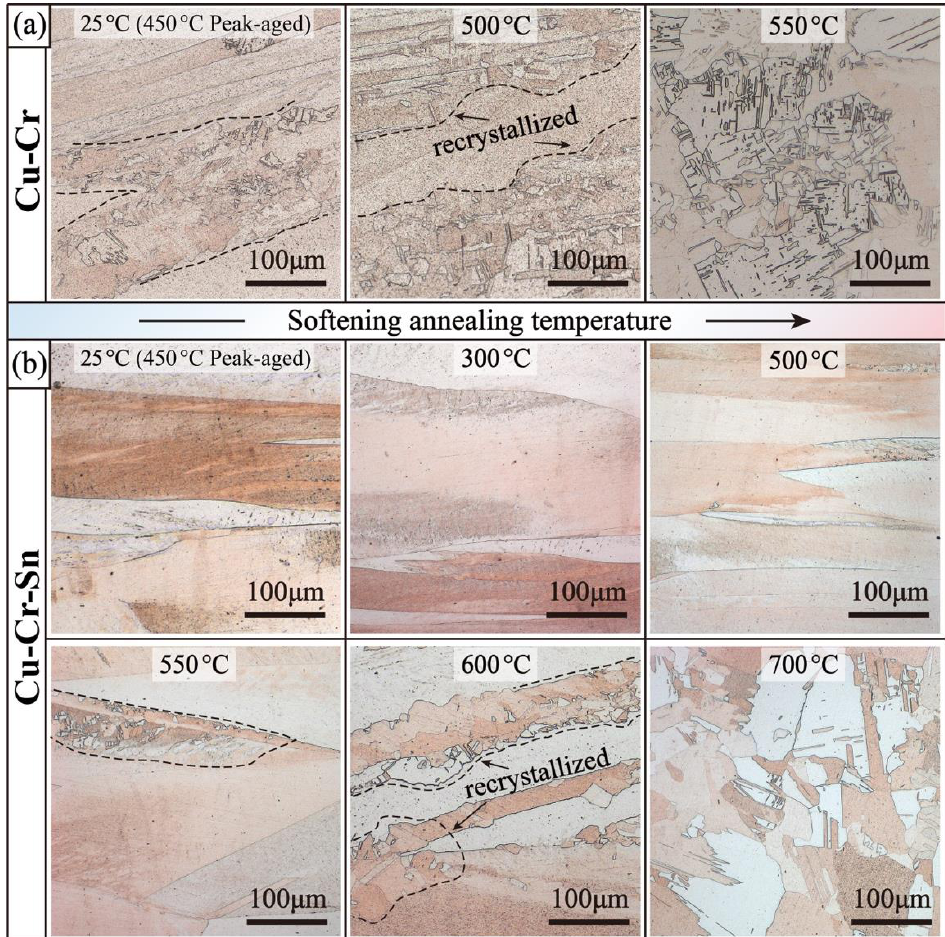
Figure 3. Recrystallization transition at different softening temperatures of: ( a ) Cu-Cr alloy; ( b ) Cu- Cr-Sn alloy.